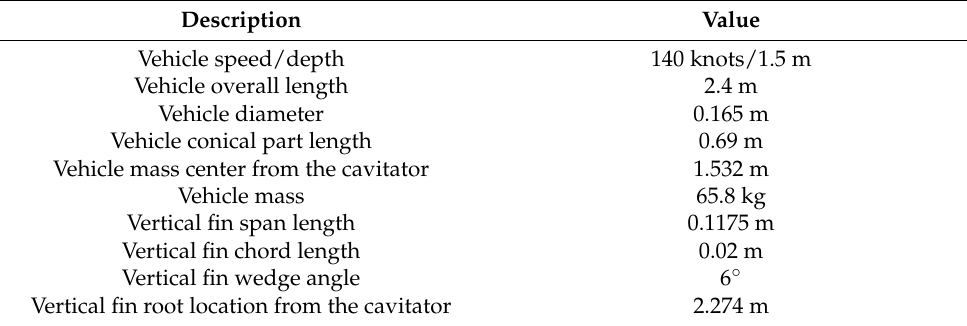
Table 2. Information for the cavitator